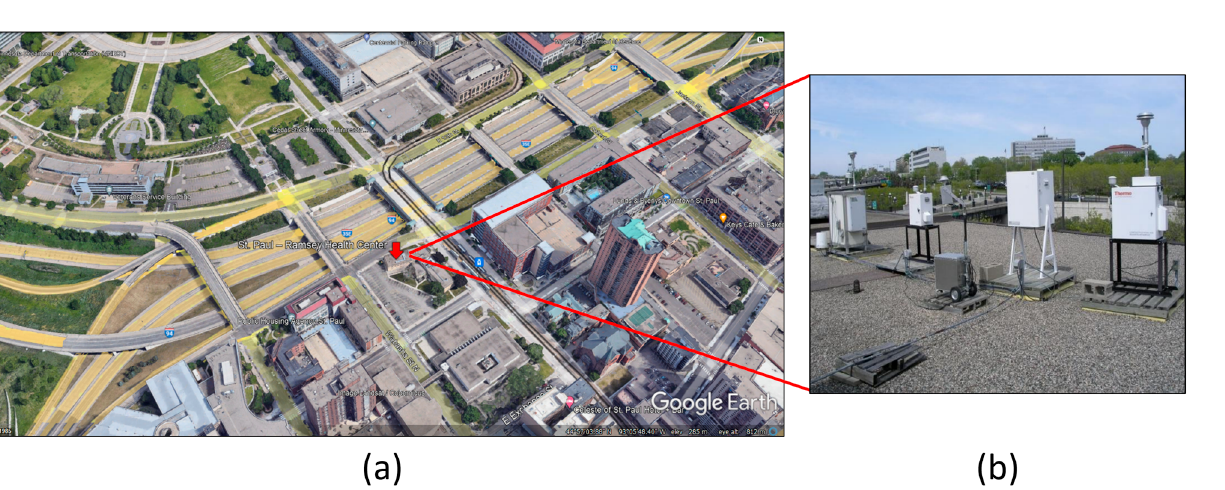
Table 16. Modeled On-Road Air Concentrations Compared to Annual Mean Monitored Concentra- tions at the Saint Paul—Ramsey Health Center Monitoring Site.